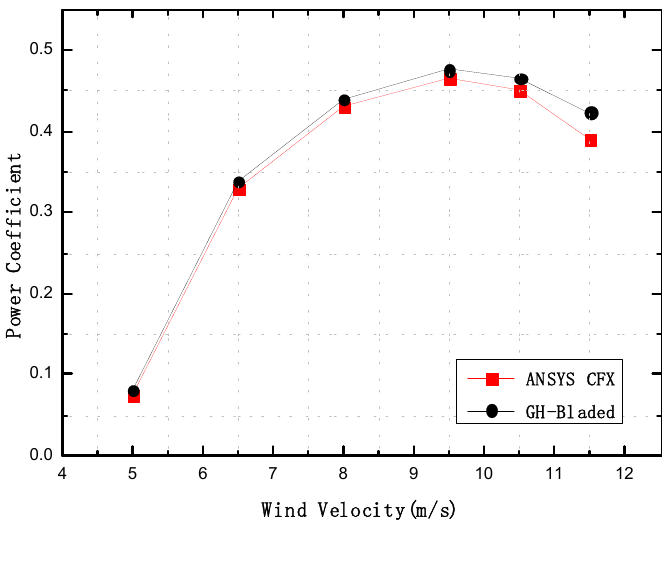
Figure 4. Power coefficient comparison between CFX and